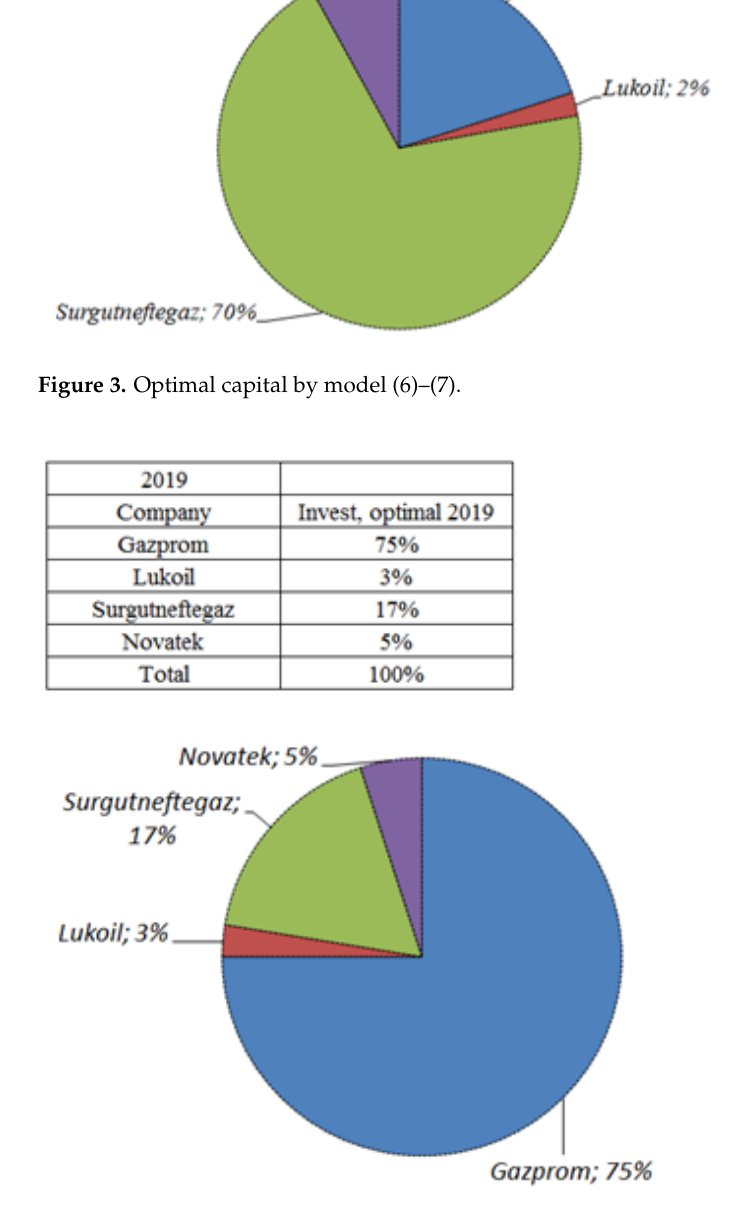
Figure 4. Optimal capital by model (8)–(9).